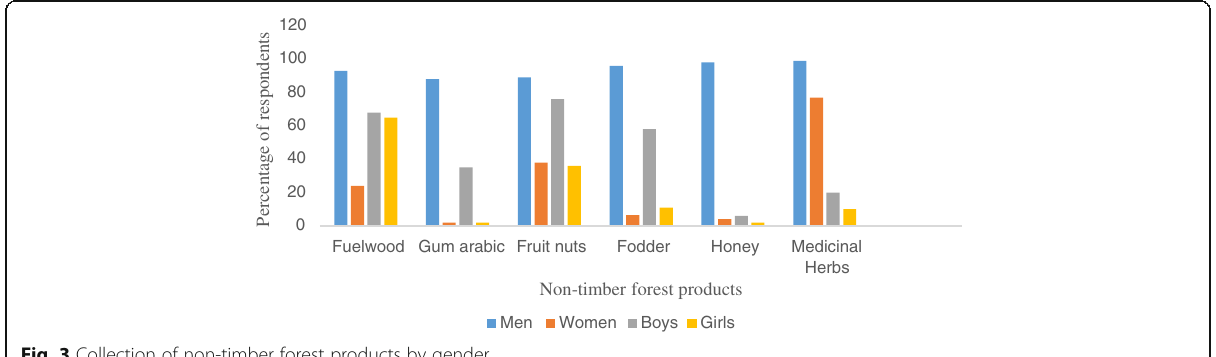
Fig. 3 Collection of non-timber forest products by gender